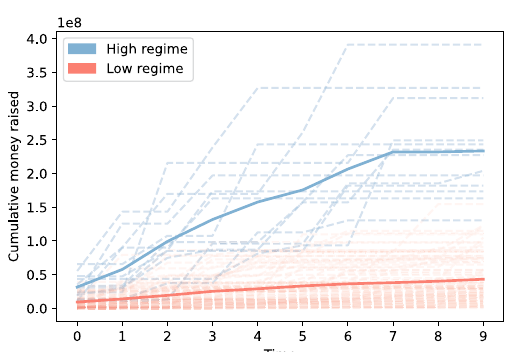
Fig. 4 k -means functional clustering ( k = 2 ) of the funding trajectories of firms belonging to the drug discovery sub-sector, observed for 10 years after the first recorded round of investments. Blue and red dashed lines represent firms in the high (‘successful’) and low regimes, respectively. Bold curves represent cluster